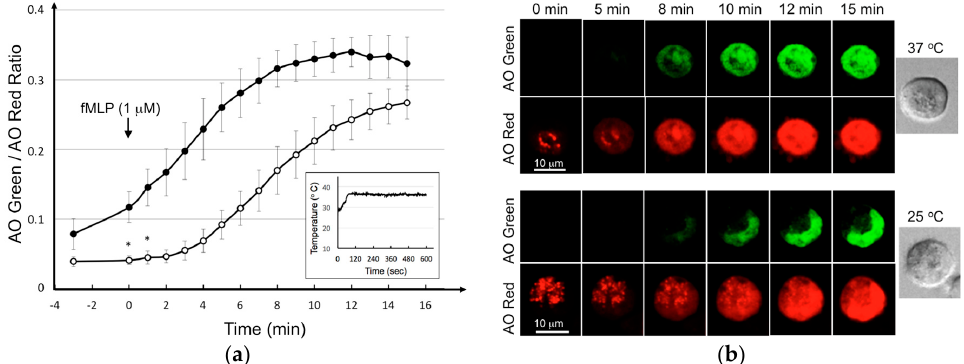
Figure 3. Release of AO from the granules of live KU-812 cells by fMLP at different temperatures. AO-loaded KU-812 cells were prepared for live confocal imaging as described in Figure 2. Cells were then challenged with fMLP (1 µM) at time zero. Bright field, AO red fluorescence, AO green fluorescence images were acquired from a confocal microscope at the time as indicated at 25 or 37 °C in an ITO-coated confocal dish. Experiments were repeated at 25 or 37 °C. The ratio of AO green to AO red from cells were calculated and plotted against time, 25 °C: open circle; 37 °C: solid circle. Results are mean ± SD from 5 single cells in one assay. Results were analyzed by Student’s t-test and the p -values less than 0.05 were considered statistically significant. All the data points have a p < 0.05 when compared to the corresponding control values except those with * ( a ); scale bar in confocal images represents cell dimension ( b ).